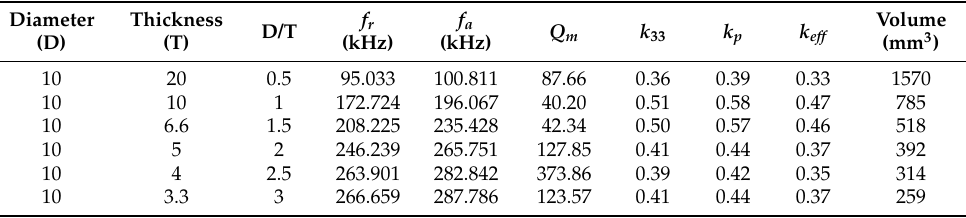
Table 1. Resonant frequency ( f r ), anti-resonant frequency ( f a ), mechanical quality factor ( Q m ), and electromechanical coupling factors of the BZT–BCT ceramics with various D/T ratios.